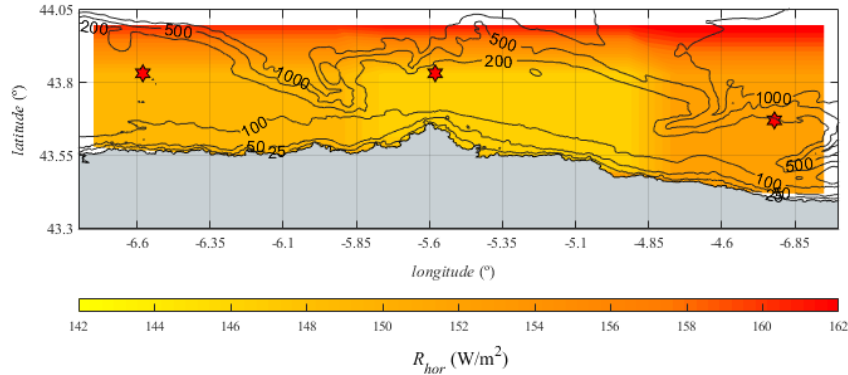
Figure 8. Average irradiance on a horizontal surface ( R hor ) off Asturias. The three study sites (West, Centre and East) are marked with red stars. (Water depths in m).